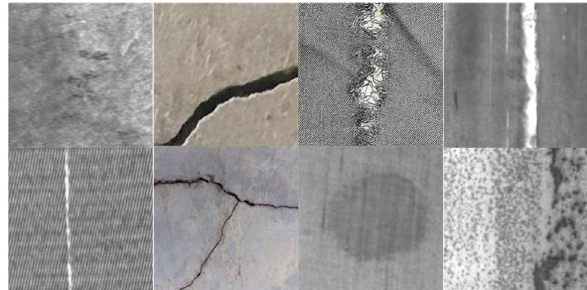
Fig. 10 Several different categories of defect